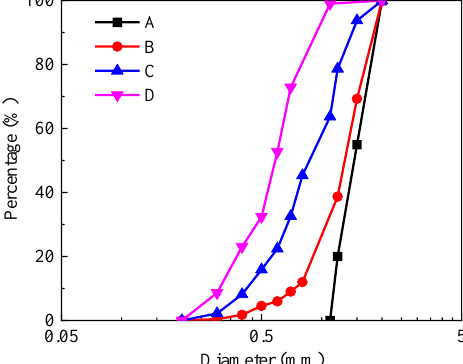
Fig. 4 Particle size distributions of compacts A – D